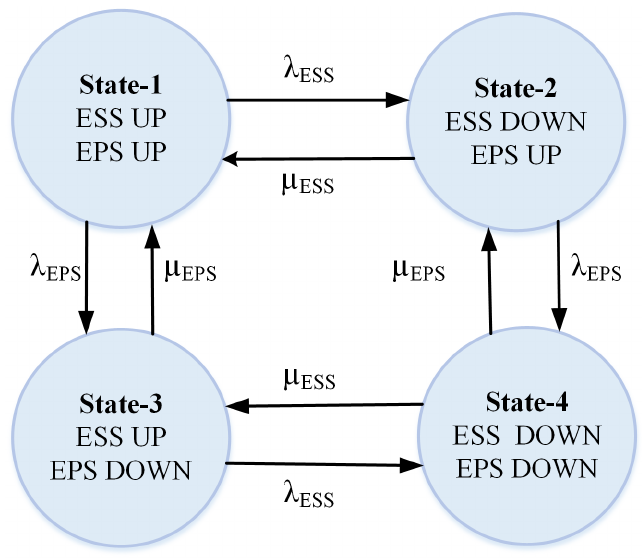
Figure 6. State-space diagram of the PEV